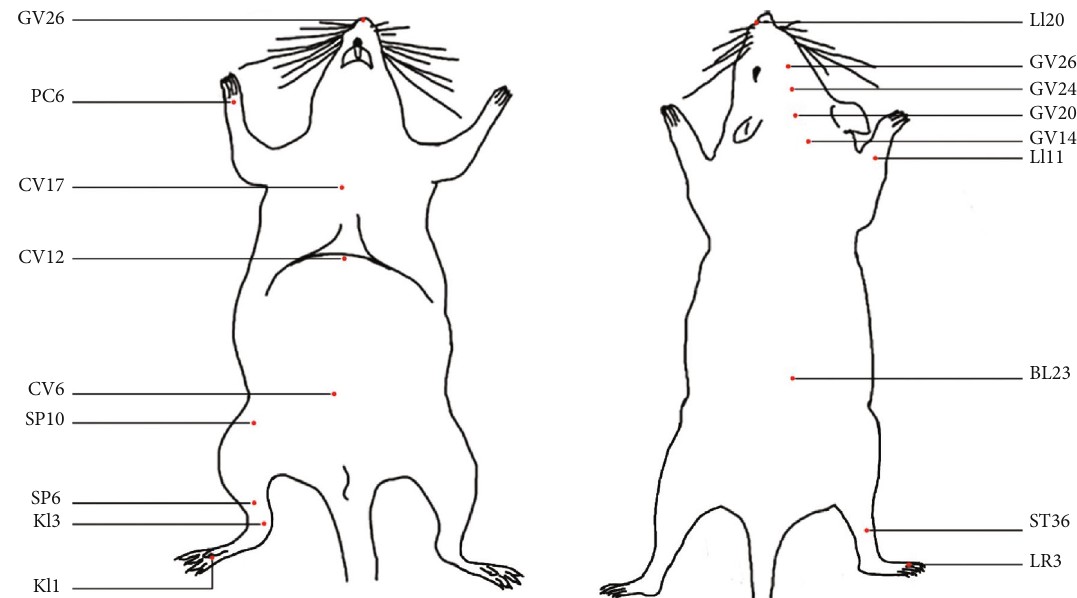
Figure 1: The locations of acupoints in